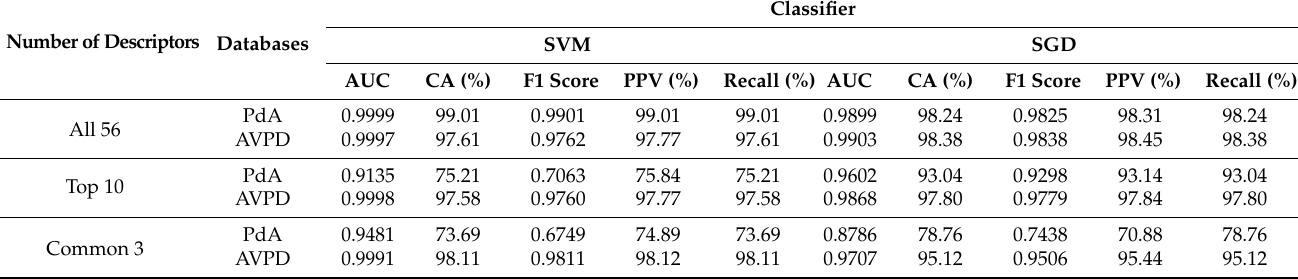
Table 14. Classifier performance measures of multiclass classification for PdA and